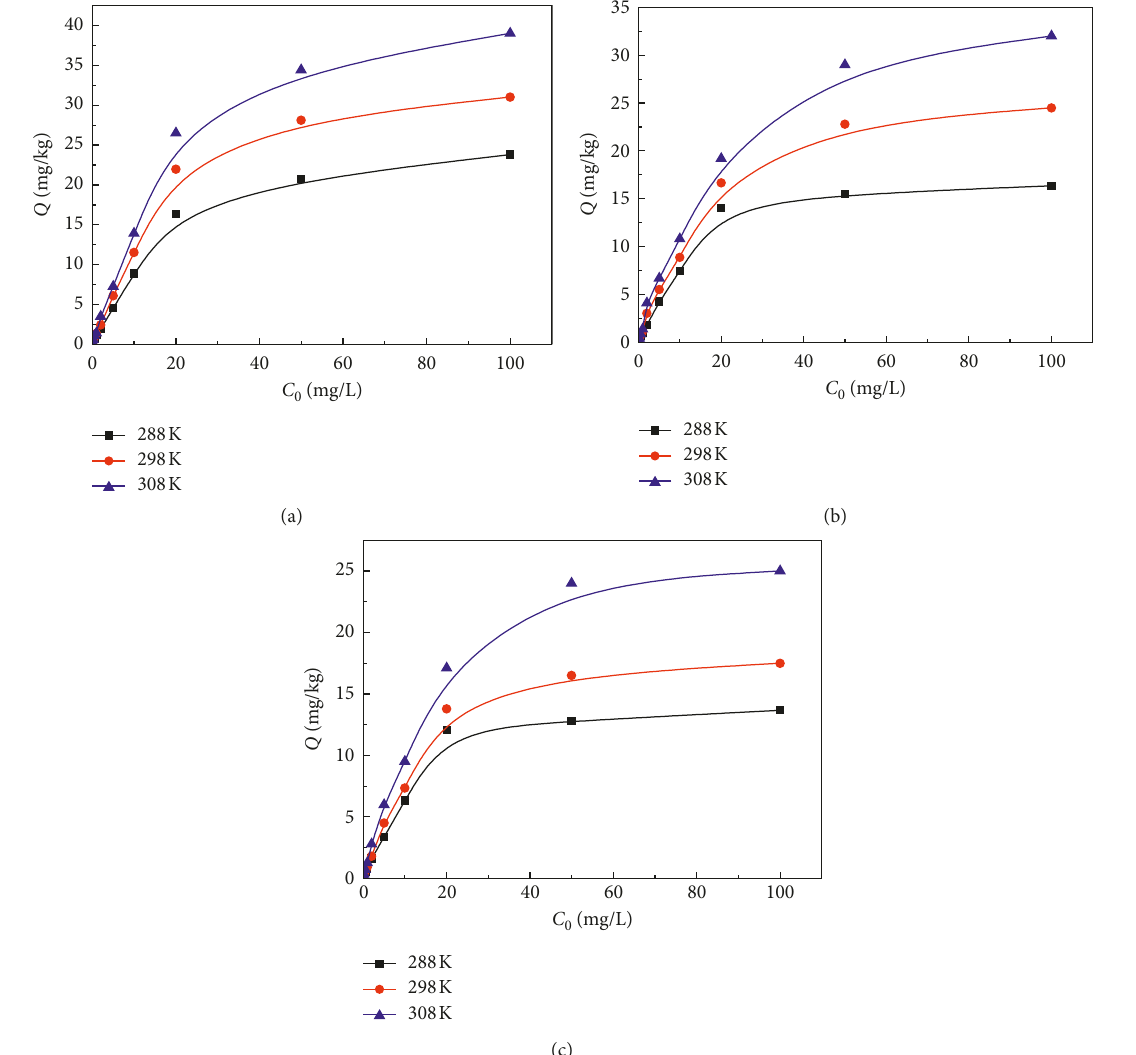
Figure 3: Adsorption isotherm curves of Cr(VI) adsorption in clay (a), silty clay (b), and silt (c). Table 2: Isotherm parameters for adsorption of Cr(VI) in different aquifers at different temperatures.